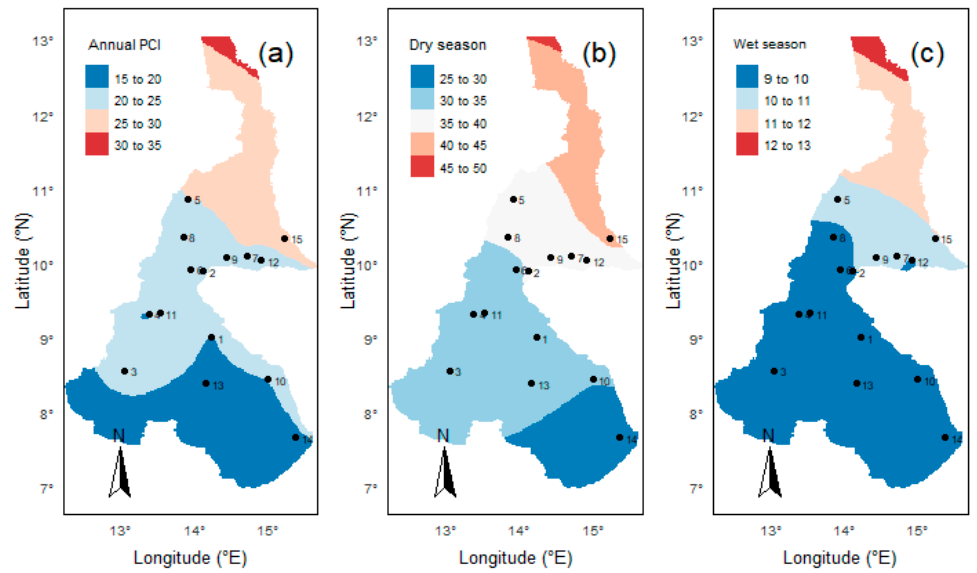
Figure 2. Spatial map of the mean value of ( a ) the annual precipitation concentration index (PCI), ( b ) dry season PCI dry , and ( c ) rainy season PCI wet in the Sudano-Sahelian region of Cameroon. Table 4. Innovative trend analysis (ITA) slopes for PCI, PCD, and PCP. Significant changes (i.e., at the 90% level) are indicated in bold.